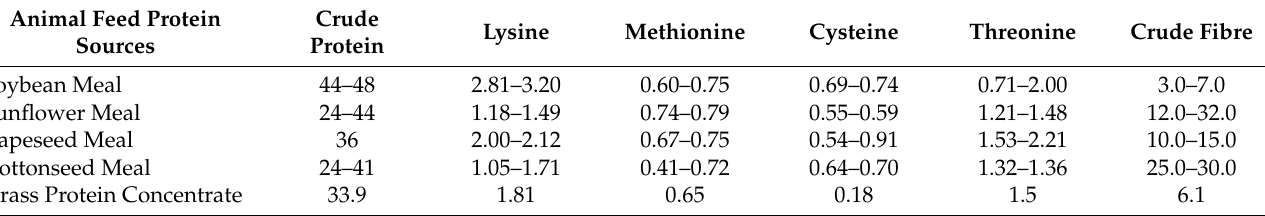
Table 6. Crude fibre, crude protein and amino acid profile of oil seed meals